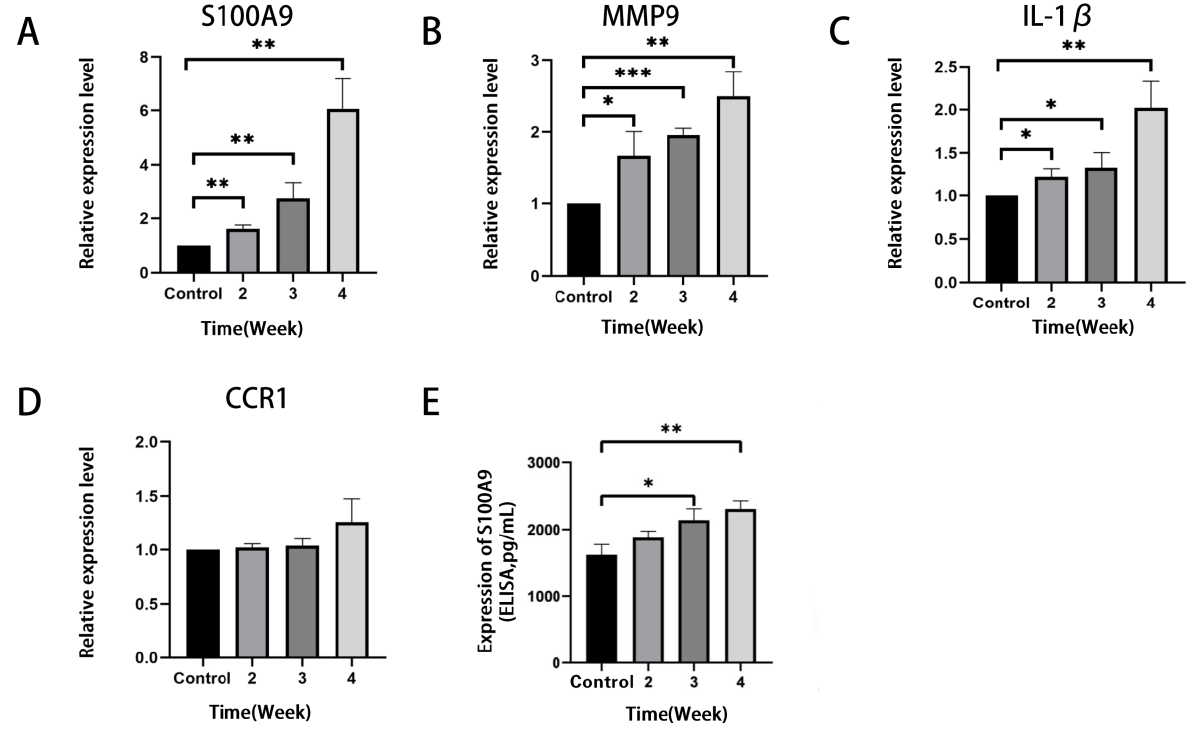
Figure 5. Verification of the expression level of the top four most significantly up-regulated DEGs in lung tissues of the mice before and after irradiation. The mice in the control group did not receive irradiation, while the mice in the irradiation group were detected at 2, 3 and 4 weeks after irradiation. ( A – D ) QRT-PCR validation of mRNA levels of S100A9, MMP9, IL-1 β and CCR1 in mice lung tissues. The mRNA levels shown were the relative mRNA level compared to the mRNA level in the control group. ( E ) The level of S100A9 protein in BALF detected by ELISA. All graphs show the means ± SEM of at least three independent experiments. Statistical significance was analyzed by two-tailed t -test, * p < 0.05, ** p < 0.01, and *** p < 0.001 compared to control.